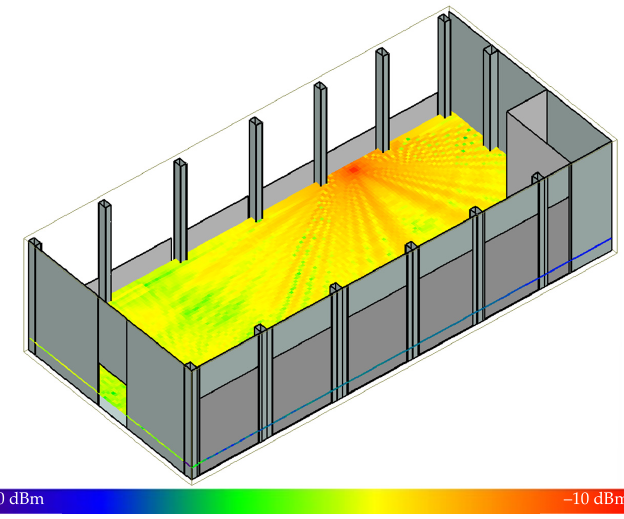
Figure 3. 3D view of the test environment model. An example RSSI spatial distribution view is shown for a transmitter generated using the ray tracing model in the Remcom Wireless InSite pro- gram.